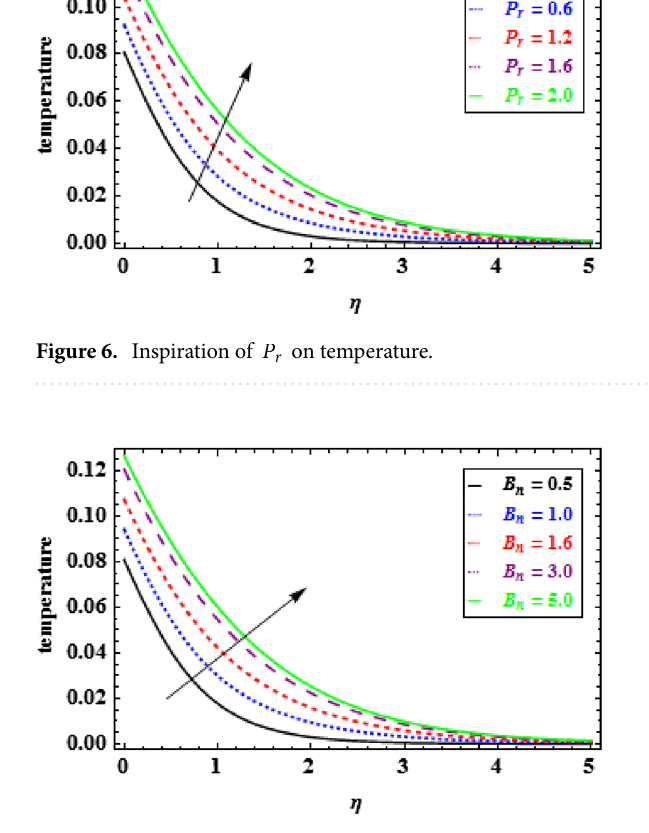
Figure 7. Inspiration of B n on